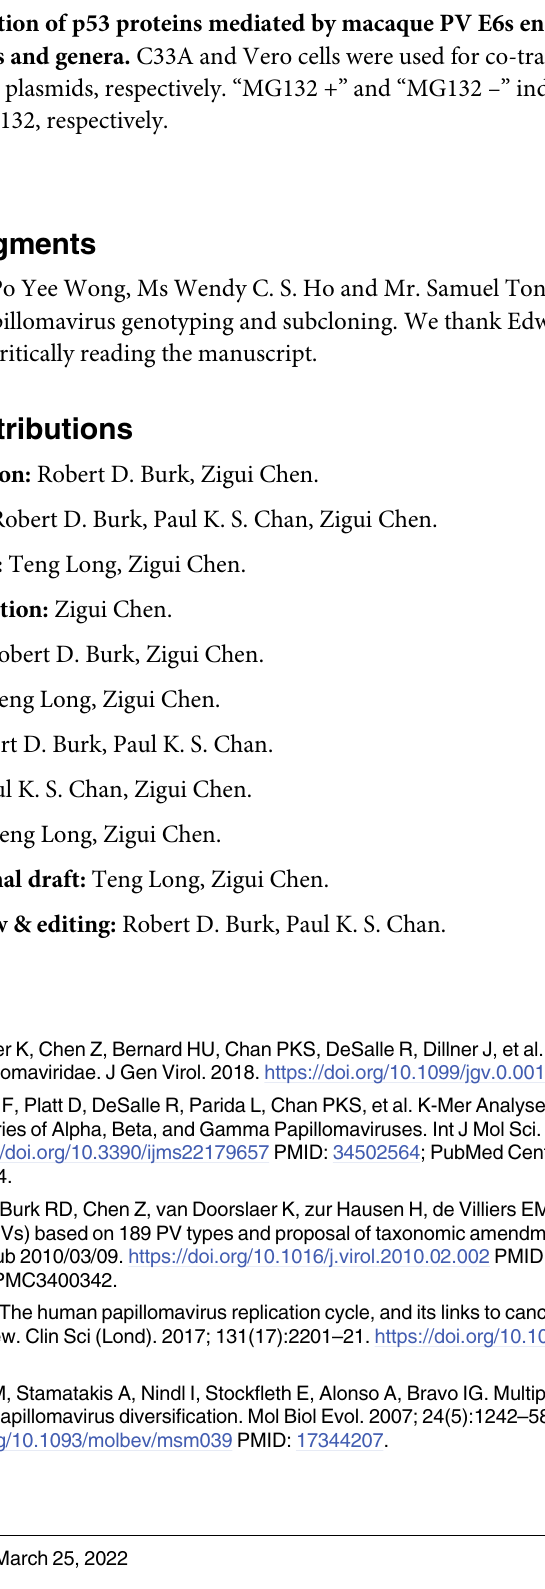
S4 Fig. Co-immunoprecipitation of HPV16 E6, human p53 and E6AP. Co-transfection of HA-E6 and Flag-p53 in H1299 cells were immunoprecipitated by HA-E6 and the proteins were immunoblotted for native p53 and E6AP. S5 Fig. Degradation of p53 proteins mediated by macaque PV E6s encoded by major NHP-PV species and genera. C33A and Vero cells were used for co-transfection of human and monkey p53 plasmids, respectively. “MG132 +” and “MG132 –” indicate treatment with and without MG132, respectively.